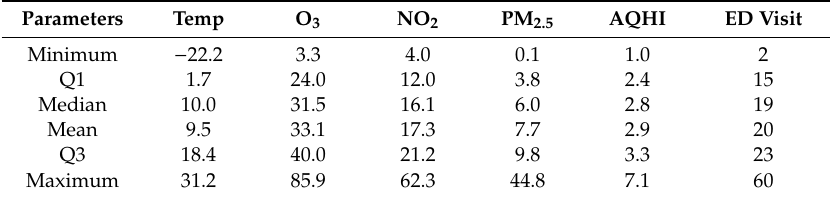
Table 2. Statistics of the daily values of the used environmental parameters. Toronto, Canada, 2004–2015. AQHI: air quality health index.